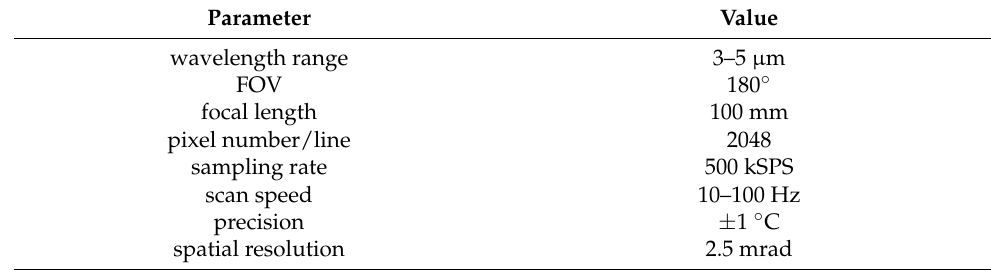
Table 1. Key technical index of infrared